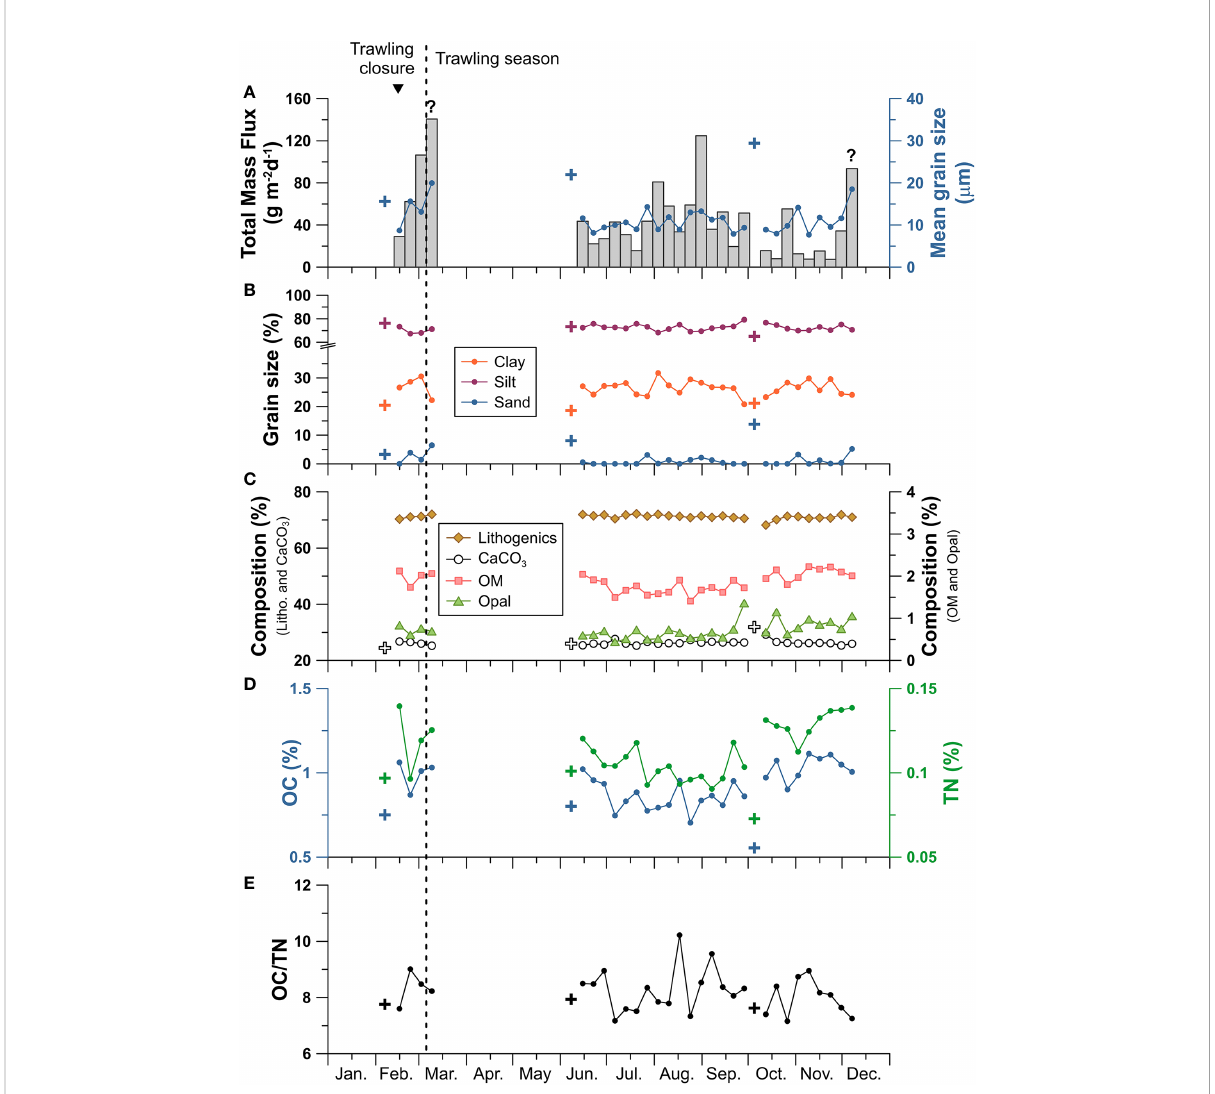
FIGURE 6 Axis-1200 time series of the sediment trap: (A) total mass fl ux (TMF) in grey bars and mean grain size in blue circles, (B) grain size classes, (C) relative concentration of the main mass composition: lithogenics (brown diamonds), calcium carbonate (CaCO 3 , white circles), organic matter (OM, pink squares), and biogenic opal (green triangles), (D) organic carbon (OC) in blue and total nitrogen (TN) in green, and (E) OC/TN molar ratio. Question marks above TMF bars indicate that the sediment trap had over fi lled in that sample and the inverted triangle indicates the occurrence of a dense shelf water cascading event. Mean values of grain size, CaCO 3 , OC, and TN of sur fi cial sediment of the sediment core retrieved on the trawled fl ank in February, June, and October (Paradis et al., 2021b) are given with crosses. Note the break in the axis of the grain size fraction (B)